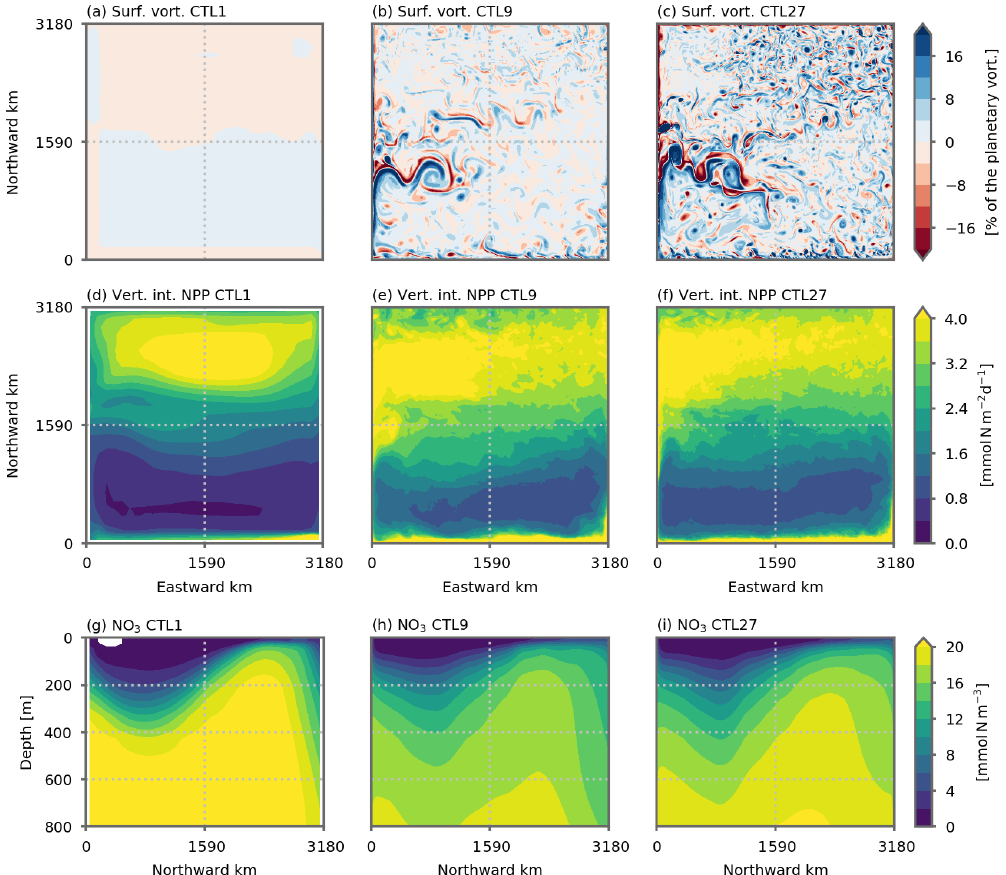
Figure 2. (a, b, c) Surface relative vorticity (% of planetary vorticity), (d, e, f) vertically integrated net primary production (NPP, mmolNm − 2 d − 1 ) and (g, h, i) vertical distribution of nitrate (zonal mean, mmolNm − 3 ) in the preindustrial control simulations at (a, d, g) 1 ◦ , (b, e, h) 1 / 9 ◦ and (c, f, i) 1 / 27 ◦ resolution. Vorticity is computed with 2d averaged velocity fields. NPP and nitrate distribution are averaged over the last 5 years of the simulations (years 66 to 70). The 1 ◦ resolution distribution is the mean of the five 1 ◦ configurations (see Figs. A4 and A2 for individual